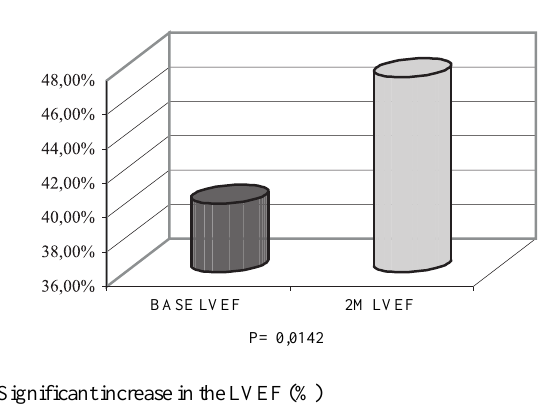
Fig. 4 - Variation of the LVEF - skeletal cell